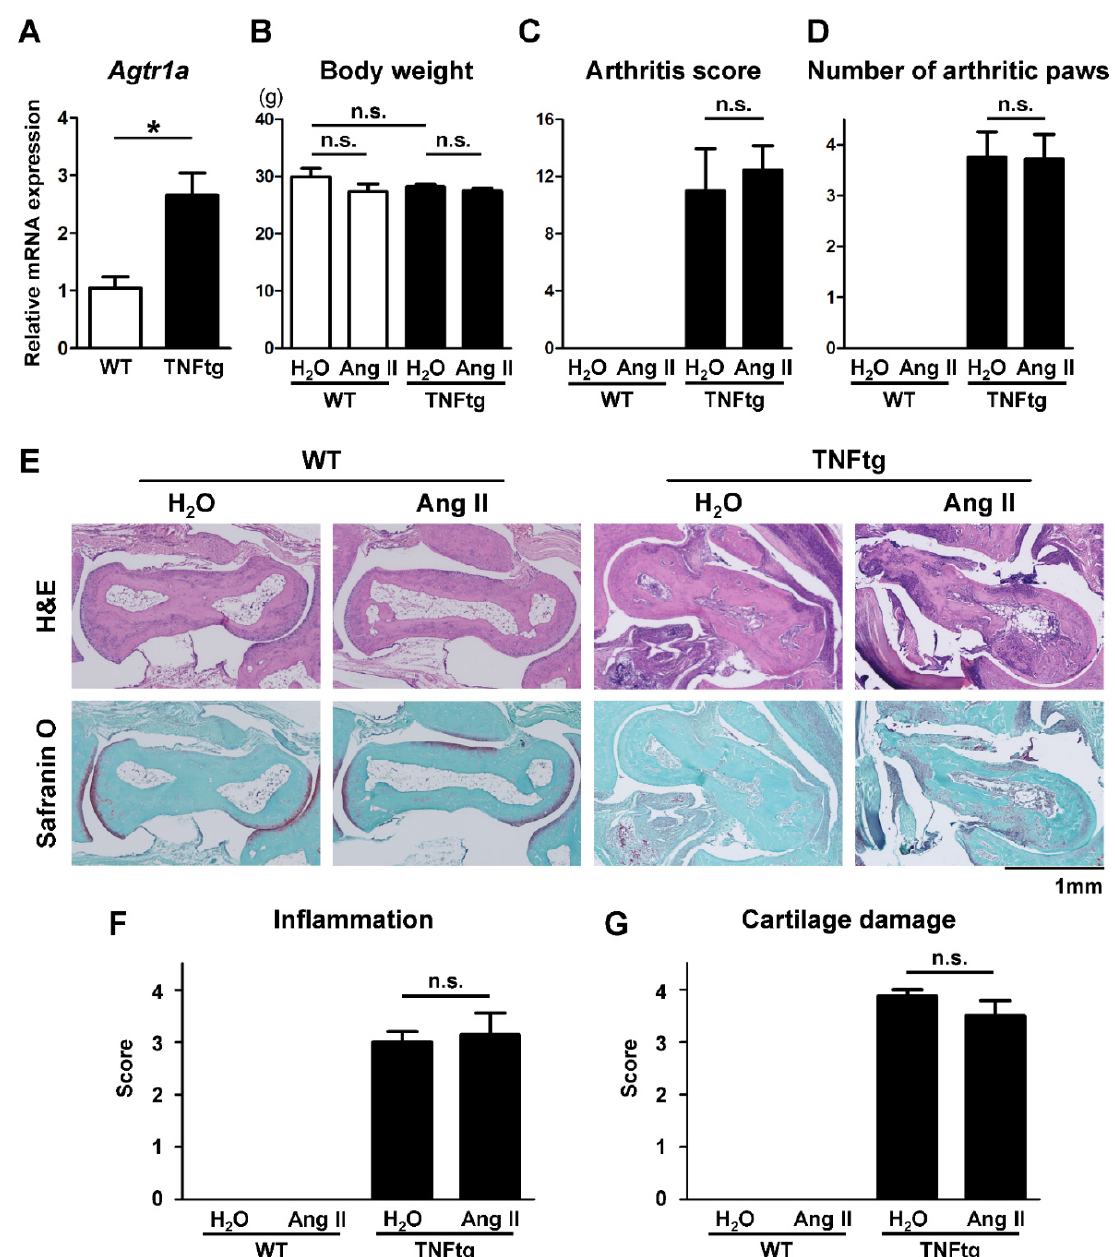
Figure 1. No significant effect of angiotensin II (Ang II) administration on the severity of inflammatory cell infiltration and cartilage damage in tumor necrosis factor-transgenic (TNFtg) mice. Ang II was administered by osmotic pumps to wild-type (WT; n = 6) and TNFtg ( n = 7) male mice from 12 to 16 weeks of age. Water (H 2 O) was administered by osmotic pumps to WT ( n = 6) and TNFtg ( n = 4) male mice as controls. ( A ) Quantitative real-time PCR analysis. Agtr1a mRNA expression levels in the right ankle joint tissue were determined. ( B ) Body weight at the age of 16 weeks. ( C ) Arthritis scores at the age of 16 weeks. ( D ) The numbers of arthritic paws with an arthritis score of 2 or higher. ( E ) Representative images of stained sections around the talus bones of indicated mice; sections were stained with hematoxylin and eosin (H&E) and Safranin O; original magnification ×40. ( F , G ) Histological scores of inflammation ( F ) and cartilage damage ( G ). Values are the mean ± SEM. n.s., not significant. *, p < 0.05. 2.2. No Significant Effect of Ang II Administration on the Severity of Inflammatory Cell Infiltration in TNFtg Mice.